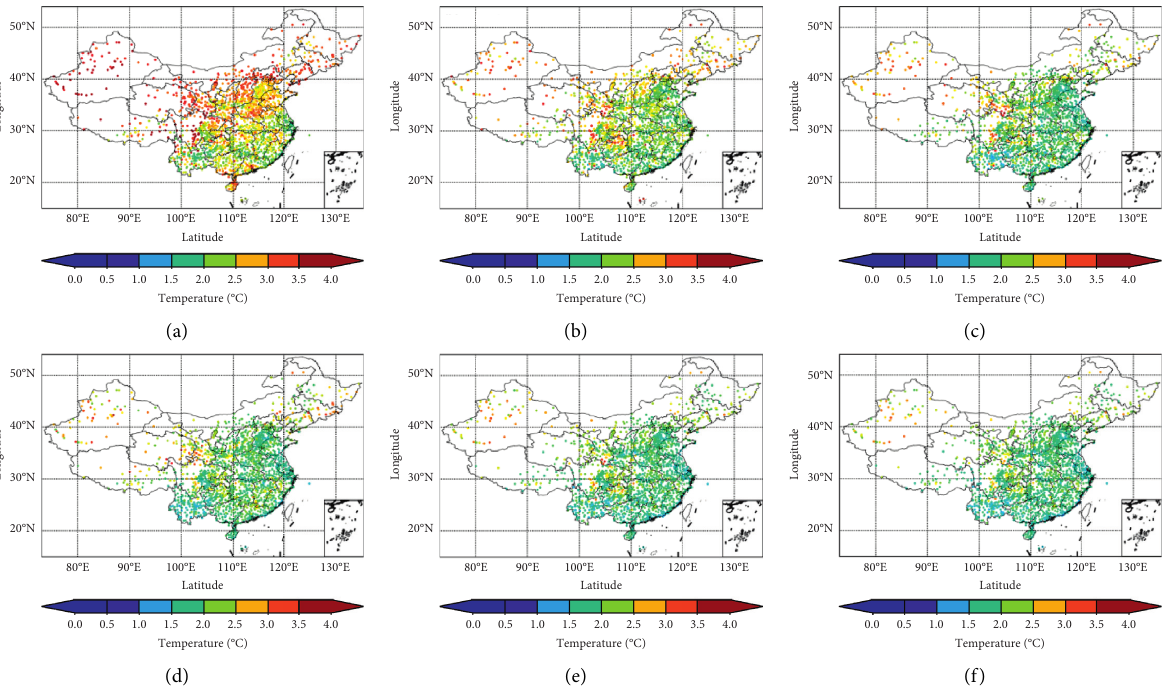
Figure 7: Spatial distribution of RMSE for six machine-learning models. (a) MLR-RMSE. (b) RF-RMSE. (c) KNN-RMSE. (d) DNN-RMSE. (e) GBTD-RMSE. (f)